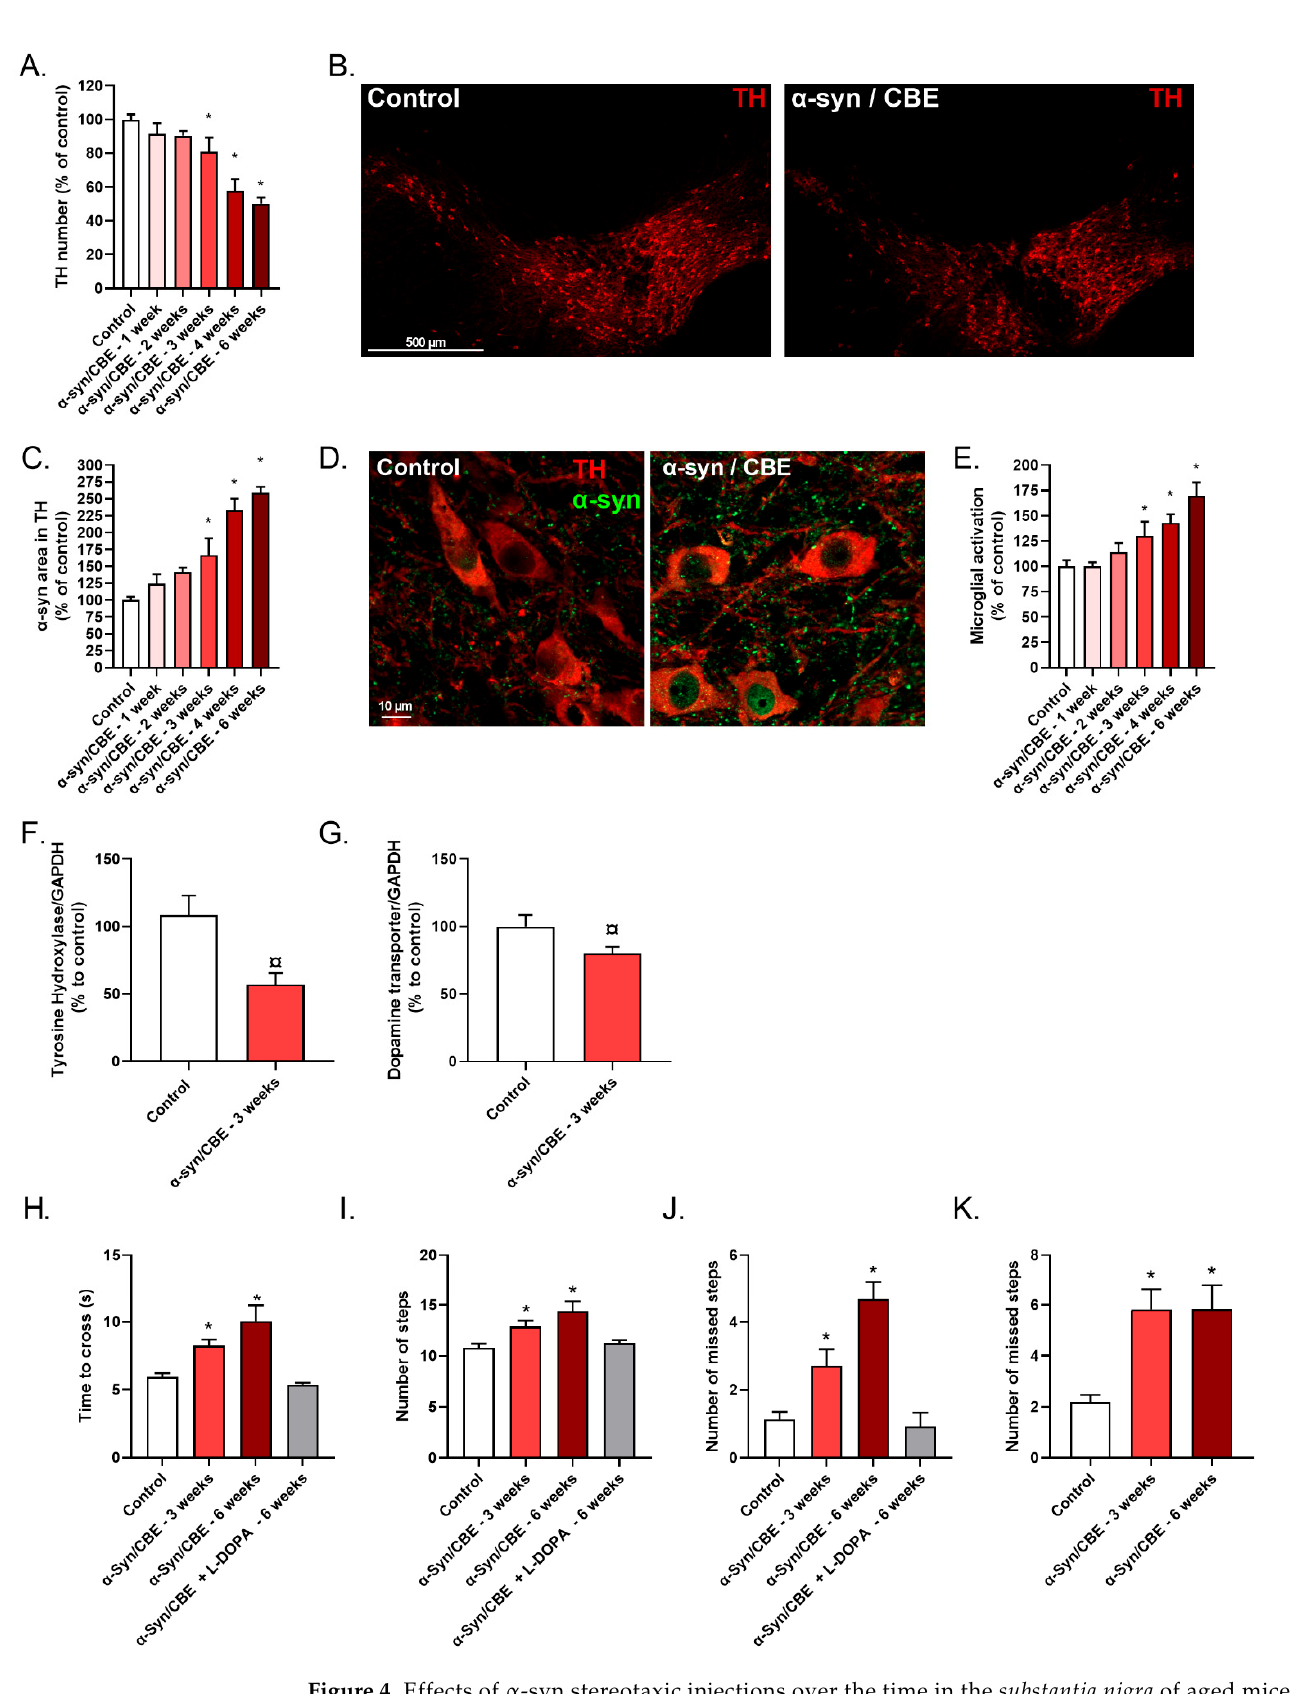
Figure 4. Effects of α -syn stereotaxic injections over the time in the substantia nigra of aged mice and on motor coordination in aged mice. ( A ) Number of TH(+) neurons (control = 79 ± 6)